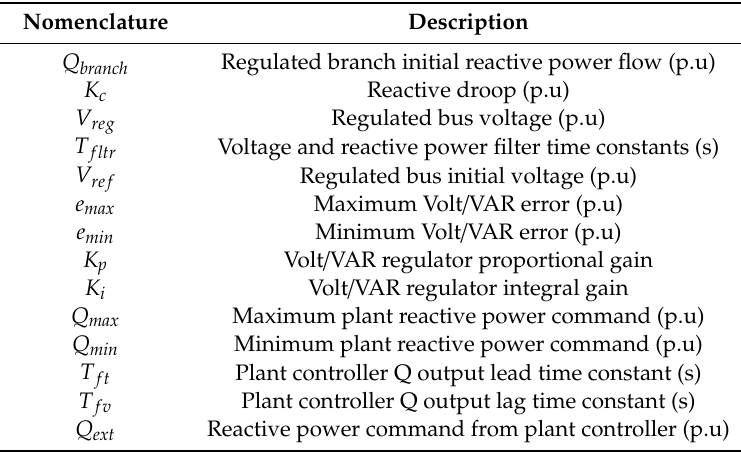
Figure 3. Control block diagram of reactive power-voltage droop control. Table 1. Nomenclature for reactive power-voltage droop control.